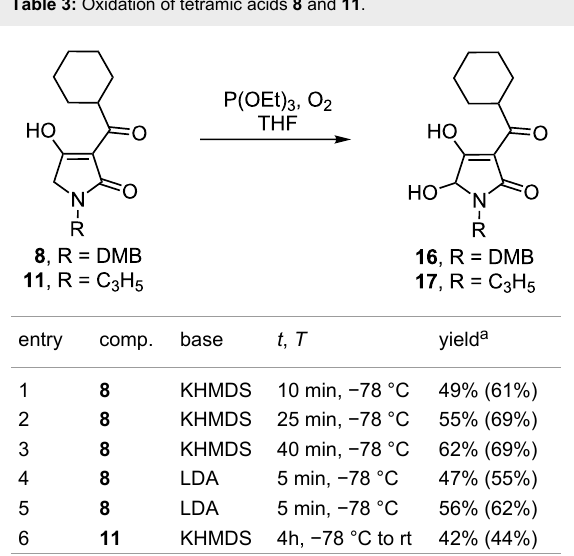
Table 3: Oxidation of tetramic acids 8 and 11